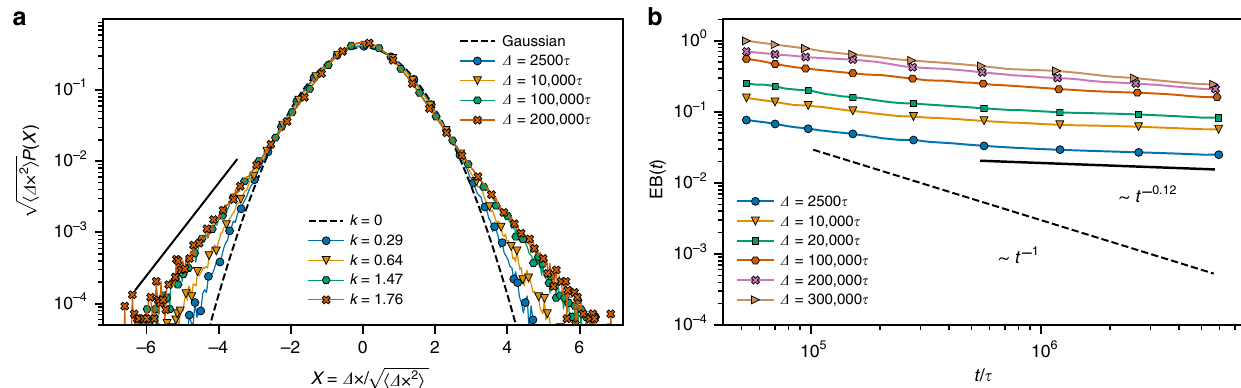
Fig. 4 Properties of the steady state. a Normalized distributions of the center of mass displacements in the x -direction for different lag times Δ measured after 2 ´ 10 6 τ . Identical distributions are found for other directions (not shown). The bottom legend contains the computed values of the kurtosis = m 2 Þ (cid:2) 3, where m κ ¼ ð m is the i -th moment of the distribution, indicating strong non-Gaussian character of the distributions upon increasing Δ . b Time 4 i 2 evolution of the ergodicity breaking parameter (7) for various lag times